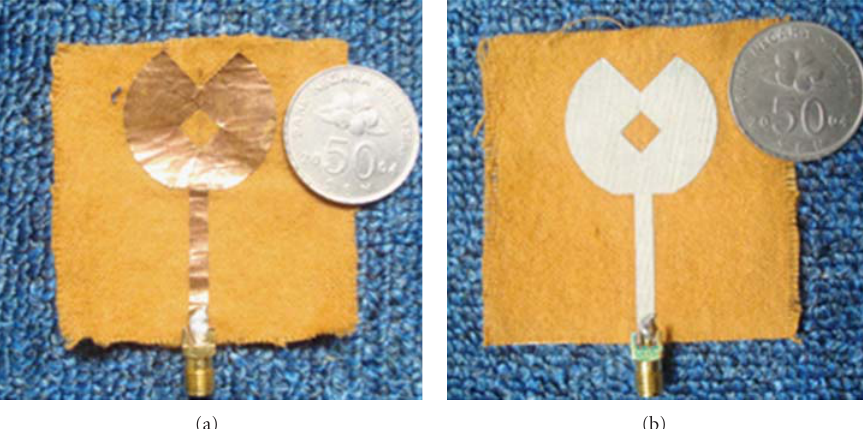
Figure 2: The fabricated wearable UWB antenna prototypes using flannel fabric with: (a) copper conducting sheet, (b) Shieldit conducting